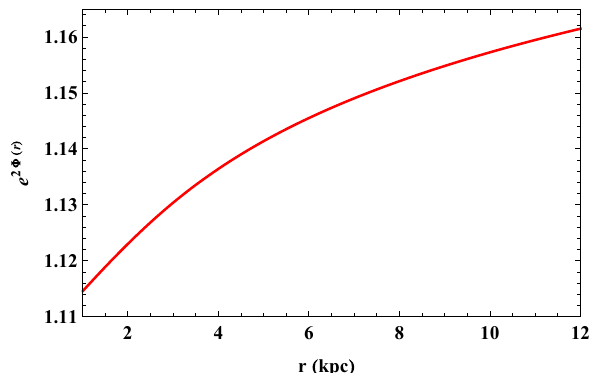
Fig. 10 e 2 (cid:11)( r ) is plotted with respect to the radial coordinate r corre- sponding to the parameters C = 0 . 05 , j = 1 , k = 1 , δ = 0 . 1, and γ = 0 . 001